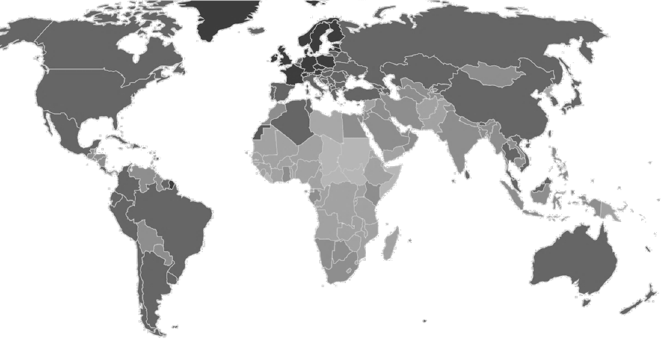
Figure 5. Overall score on total progress toward achieving the SDGs. Source: Sachs et al. (2022).